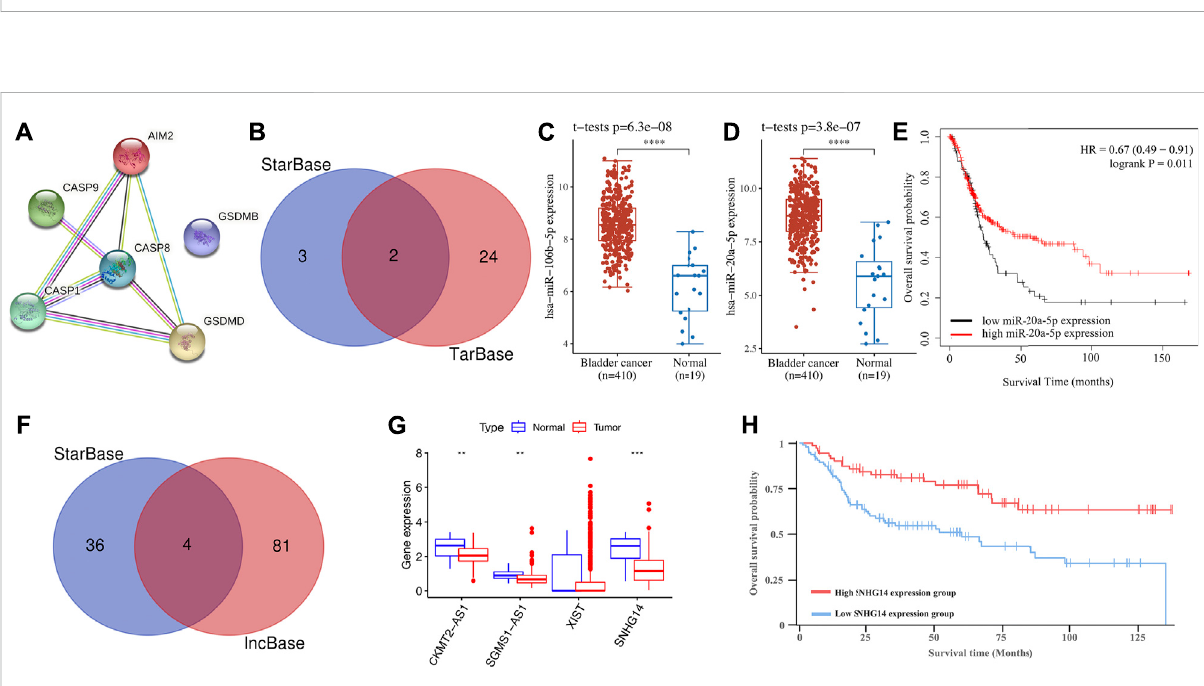
FIGURE 10 ConstructionofthelncRNA – miRNA – mRNAregulatoryaxis. (A) APPInetworkidenti fi edCASP8asthehubgene. (B) miRNAtargetspredictedby StarBaseandTarBase. (C,D) TheexpressionofmiR-106b-5pandmiR-20a-5p inbladdercancerandnormal tissues. (E) TheprognosticvalueofmiR- 20a-5p in bladder cancer. (F) lncRNA targets predicted by lncBase and StarBase. (G) The expressions of lncRNA CKMT2-AS1, SGMS1-AS1, XIST, and SNHG14 in bladder cancer tissues and normal tissues. (H) Bladder cancer patients with low SNHG14 expression had a poor overall